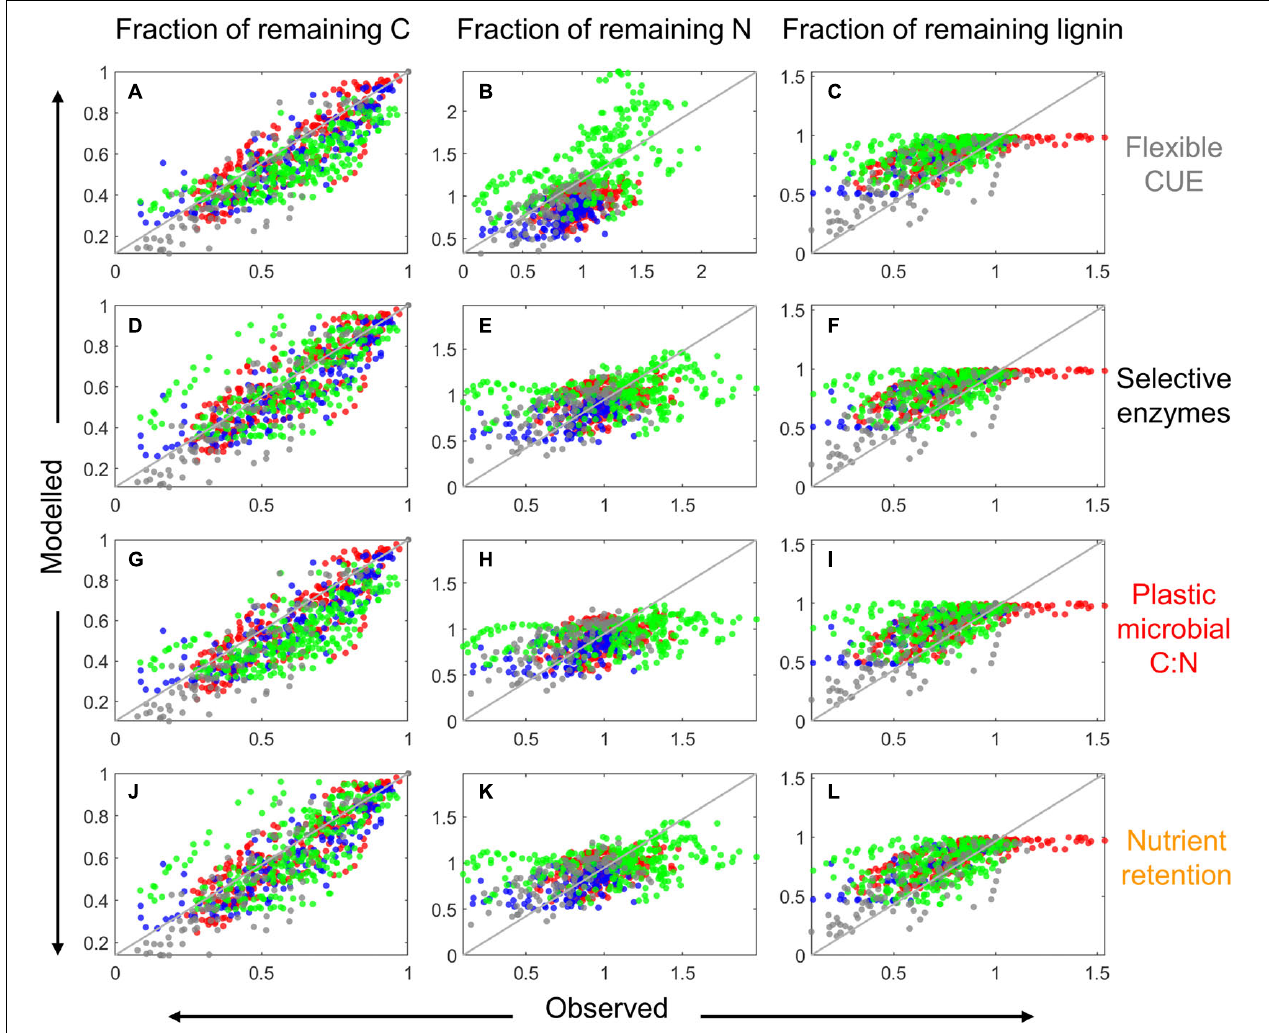
FIGURE 8 | Comparison of modeled and observed fractions of remaining total C [left column: A,D,G,J ], total N [center column: (B,E,H,K) ], and lignin ( C O ) [right column: C,F,I,L ] for the four resource use modes (as indicated on the right) when the model parameters were globally fitted. Data points are color coded according to their source: red from Berg and McClaugherty (1989), green from Osono and Takeda (2004, 2005), gray from Osono (2017), and blue from Hirobe et al. (2004); the 1:1 line is depicted as a solid gray